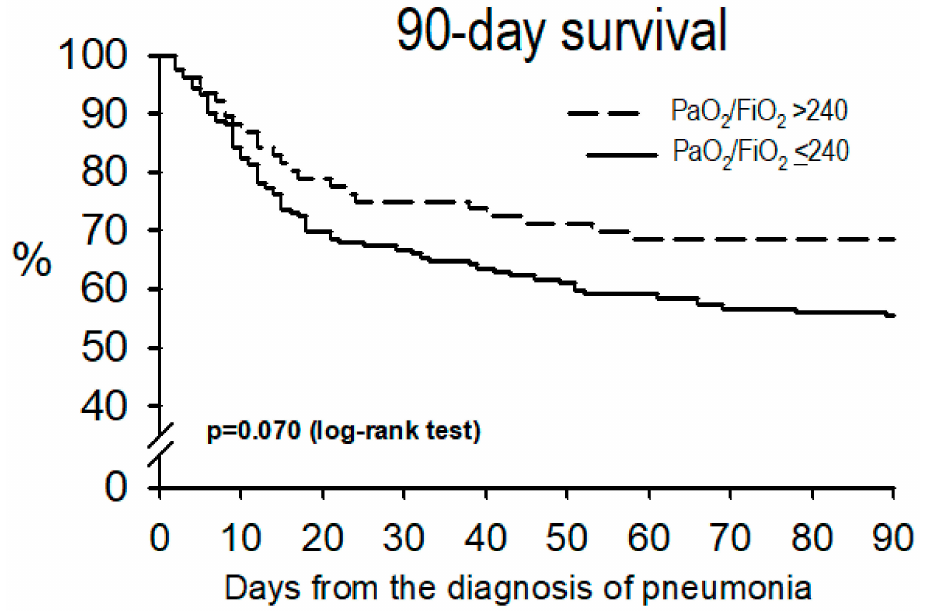
Figure 3. Survival curves at 90